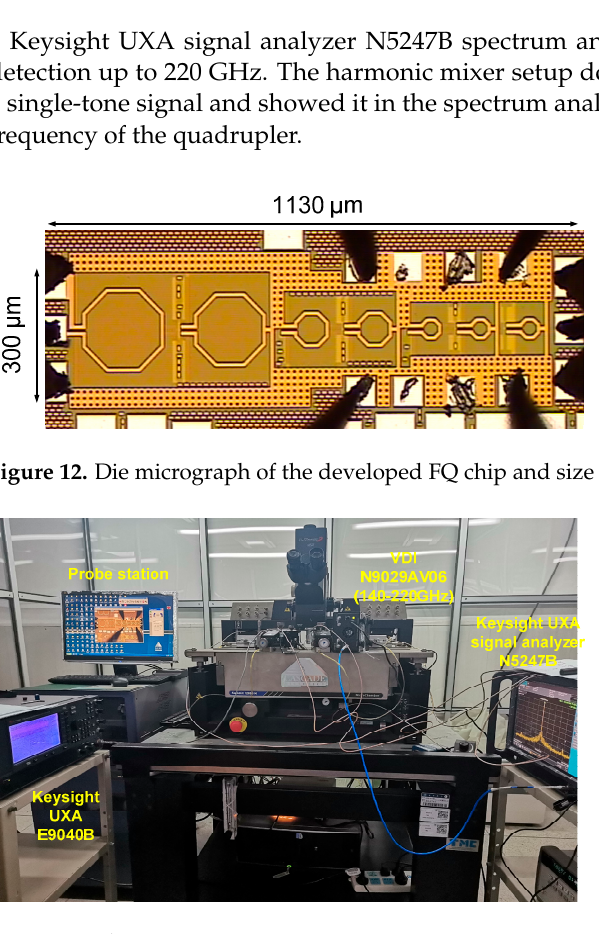
Carrier frequency 156 GHz